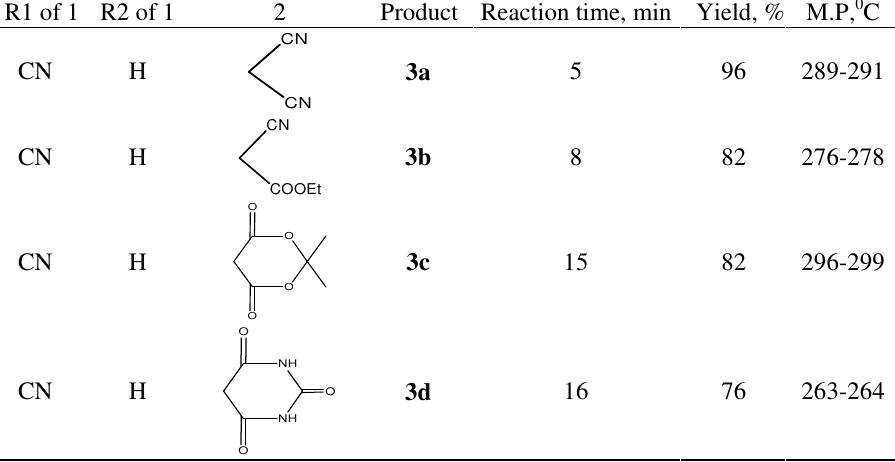
Table1. Synthesis of indole substituted alkenes from the Knoevenagel condensation of aldehydes and active methylene compounds R1 of 1 R2 of